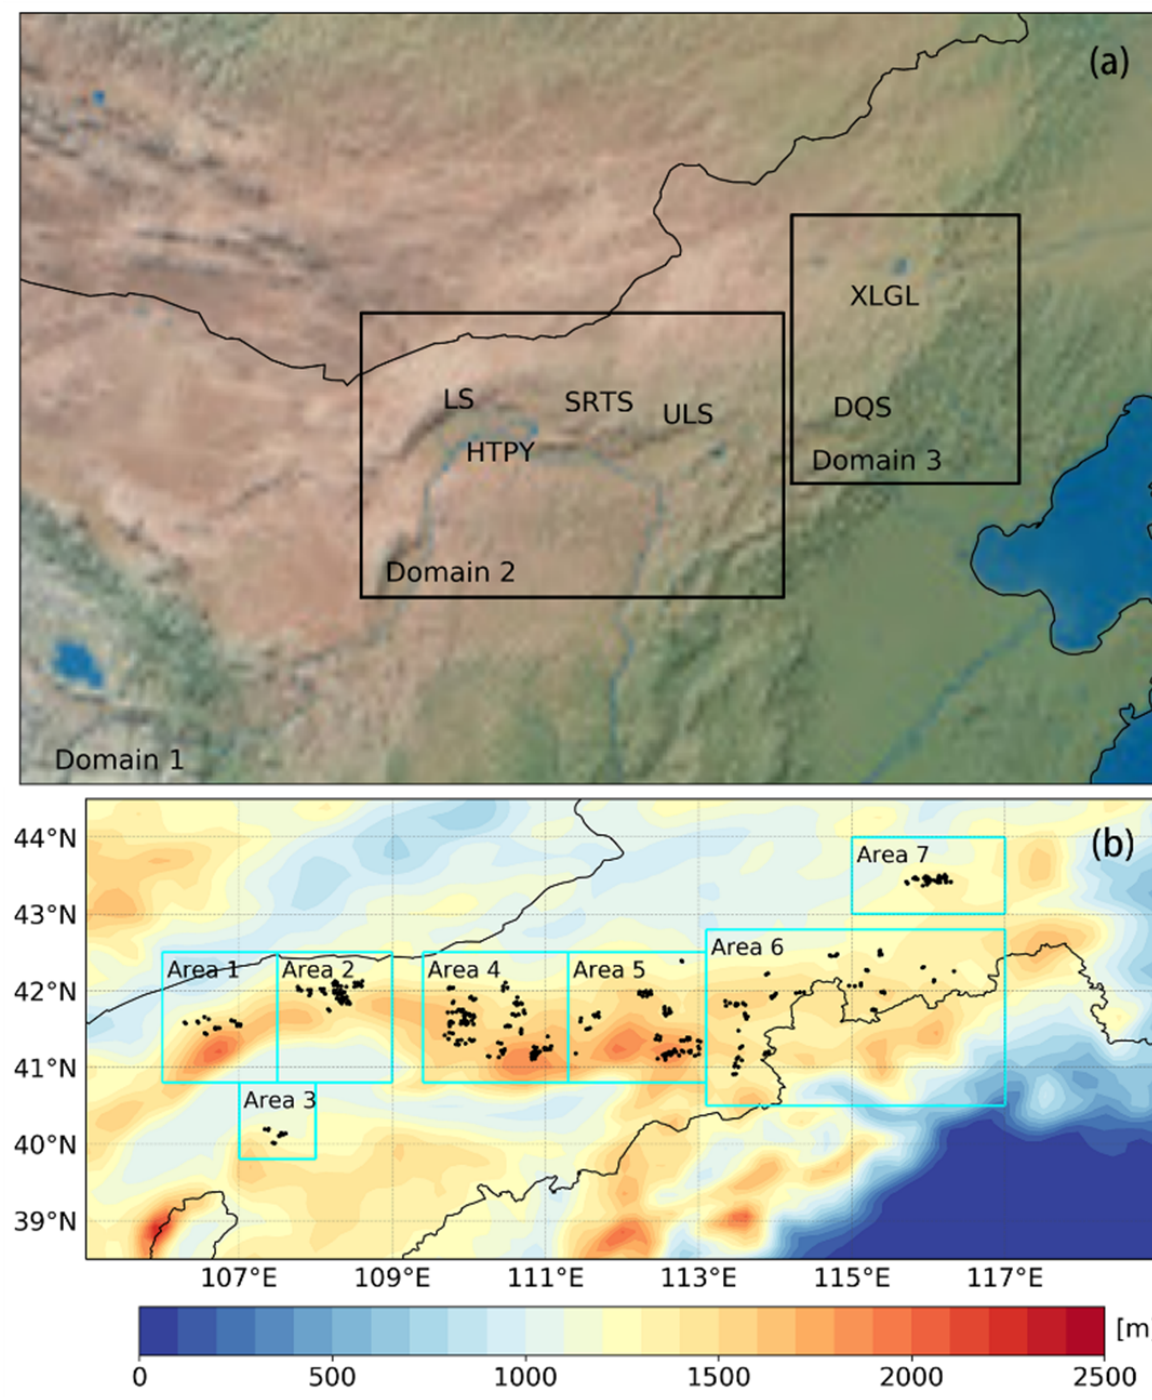
Figure 1. ( a ) Schematic diagram of the ensemble prediction domains for wind farms in the Inner Mongolia Autonomous Region. The horizontal resolution of the coarse-grid simulation domain is 13.5 km, and the horizontal resolution of the two-nested fine-grid simulation domain is 2.7 km. The colored background is the terrain. ( b ) Topography (color filled map) and distribution of test stations (black dots) in the study area. The black line in ( b ) marks the provincial boundary of the Inner Mongolia Autonomous Region, while Areas 1–7 mark the seven subregions enclosed by cyan-colored rectangles.